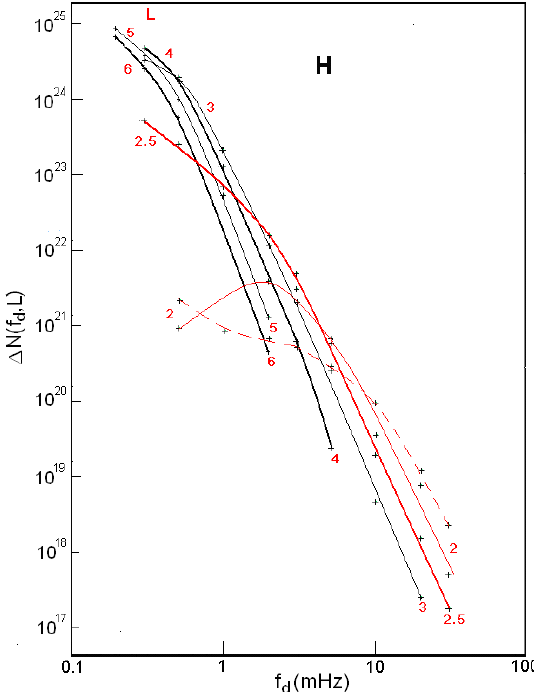
Figure 5. Frequency spectra (cid:49)N(f d ,L) for protons of the ERB at L = 2, 2.5, 3, 4, 5, and 6, plotted for periods of maximum solar ac- tivity. The values of L corresponding to each spectrum and spectra at L = 2 and 2.5 are highlighted in red. The red dotted line shows the spectrum (cid:49)N(f d ,L) of the ERB protons at L = 2, constructed from data during minimum periods of solar activity (see Kovtyukh, 2020). For clarity, thin curves are interspersed with thick